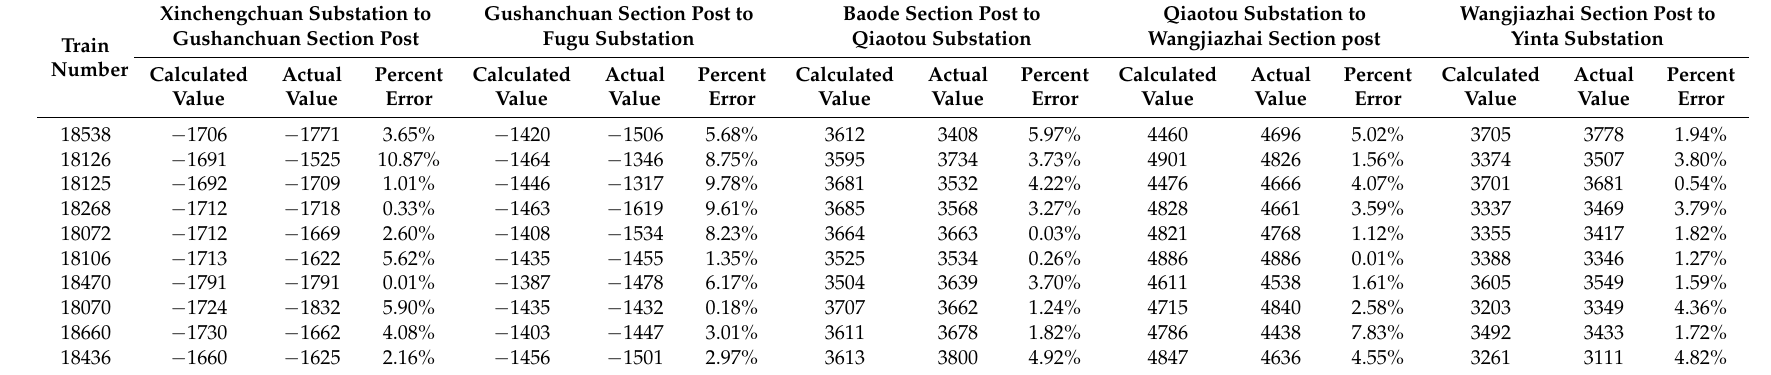
Table 4. Verification results of interval energy consumption and regenerative braking energy for upstream AC trains.